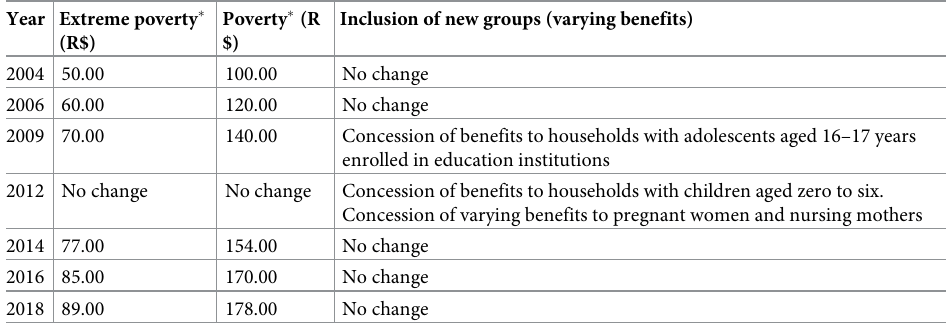
Table 2. Changes in the eligibility criteria and inclusion of new groups of beneficiaries.